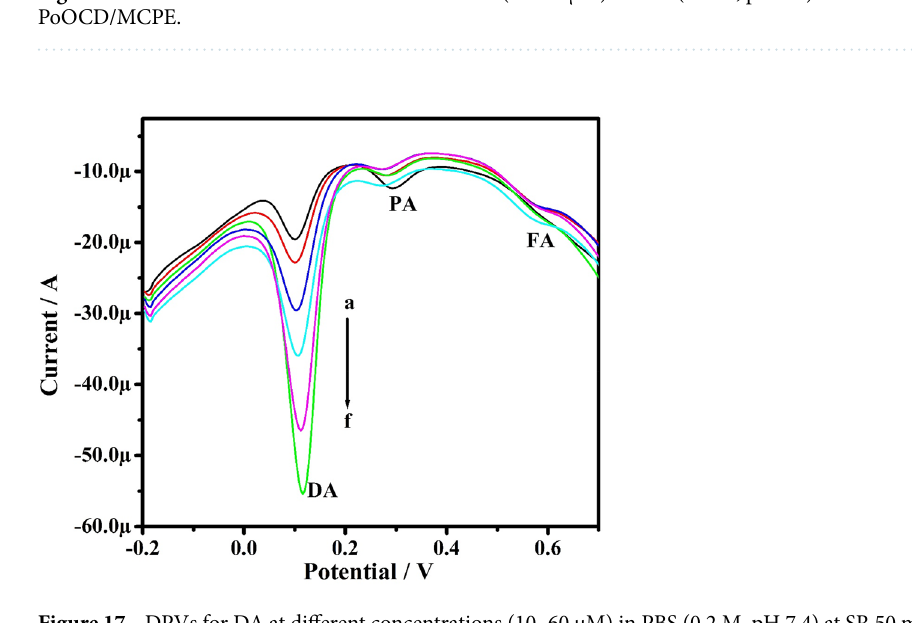
Figure 17. DPVs for DA at different concentrations (10–60 µM) in PBS (0.2 M, pH 7.4) at SR 50 mVs −1 at PoOCD/MCPE.